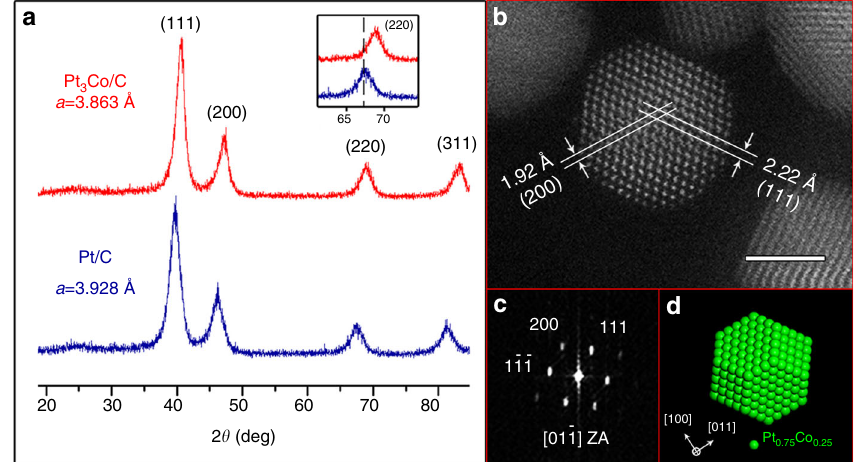
Fig. 1 XRD and STEM characterization results of the Pt 3 Co/C sample. a X-ray diffraction patterns of Pt 3 Co/C and Pt/C samples. The inset is an enlarged region of the (220) diffraction peaks of both samples. b HAADF-STEM image of a Pt 3 Co NP along the ½ 01 1 the NP in b , illustrating the disordered fcc structure with an absence of (100) superlattice spots. d Projection of a truncated octahedron model along the < 110 > zone axis. Green spheres correspond to randomly distributed Pt and Co atoms in the disordered Pt